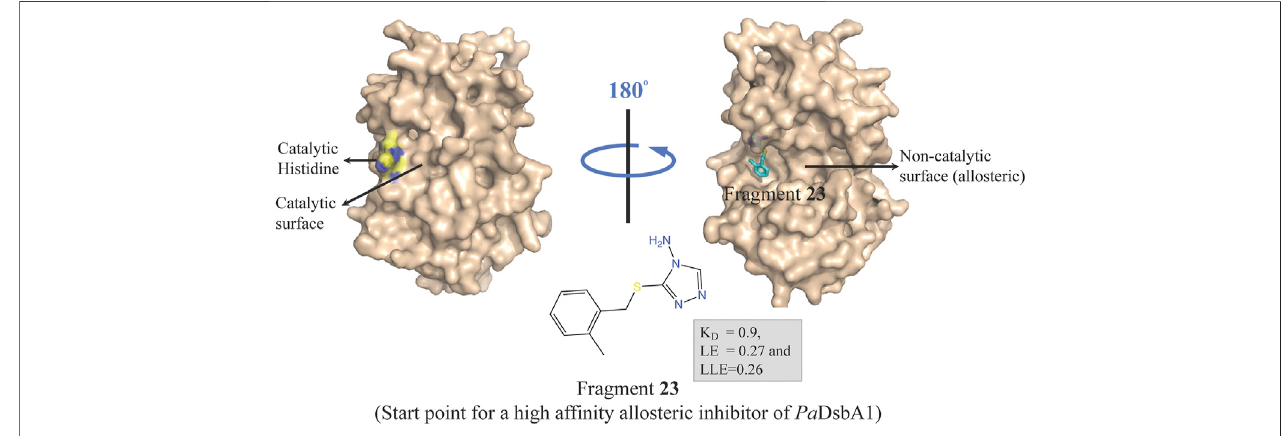
FIGURE 5 | Binding site of fragment 23 (obtained by a FBDD campaign) to the non-catalytic allosteric surface site of Pa DsbA1 as revealed by the Pa DsbA1- 23 complex (pdb id 5dch) obtained using X-ray crystallography (Mohanty et al., 2017).